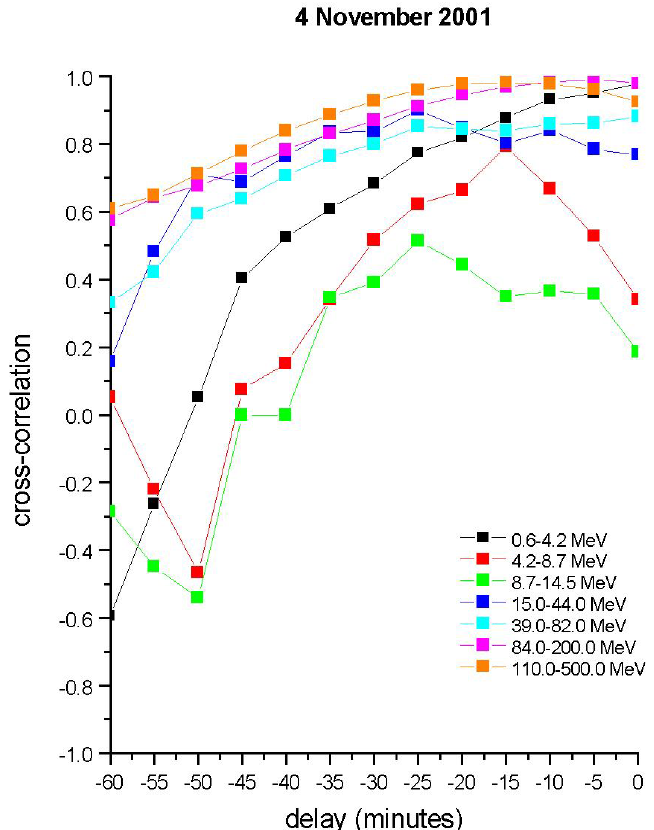
Fig. 9. Cross-correlation coefficients between A(t) and differential J 1 / 2 (t − τ) calculated for the first hour of 4 November PCA event (16:55 UT–17:55 UT).